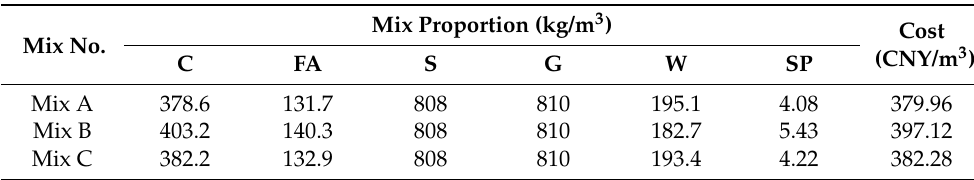
Table 18. The mix proportions and costs of different mix points in strength-based mix design. Mix No.